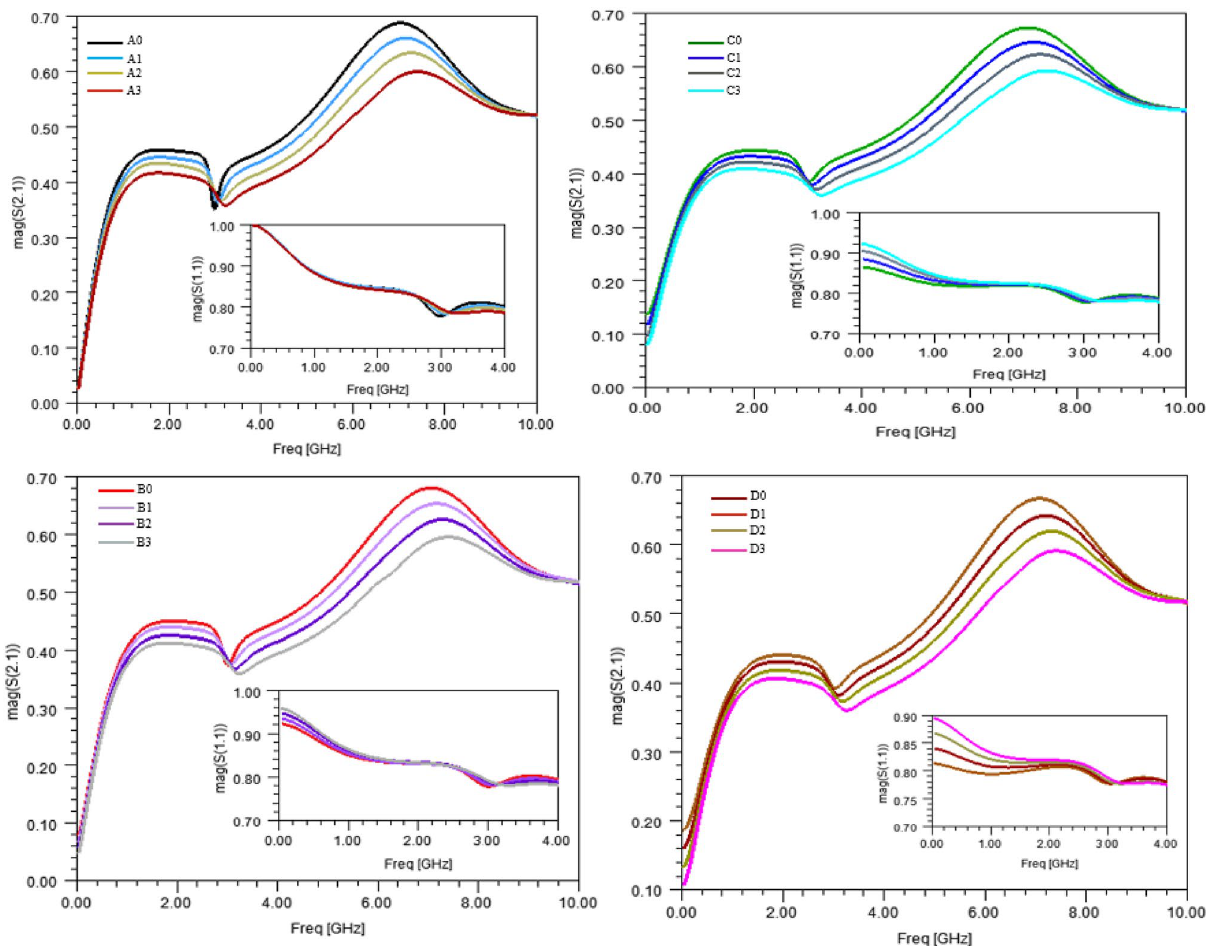
Figure 14. Simulated transmitted (S21) and reflected (S11) S-parameters of the sensor with various modelled